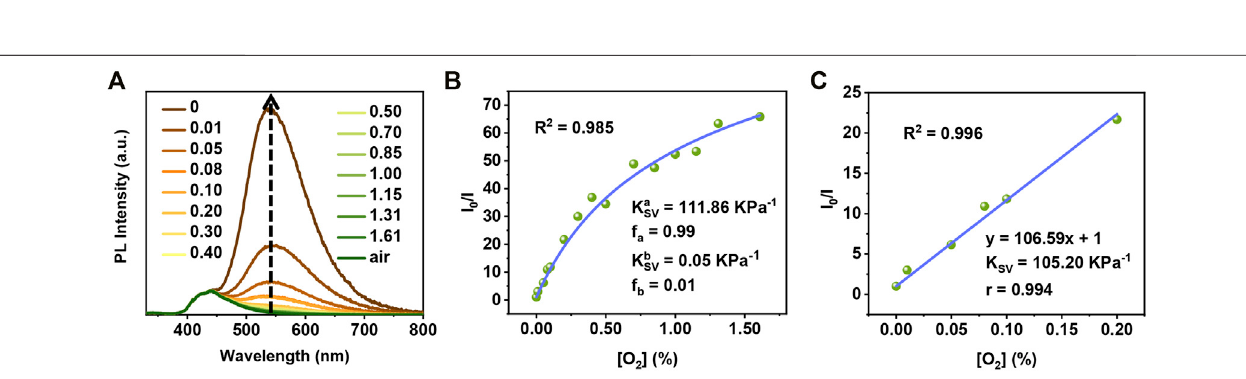
FIGURE 4 | (A) Emission spectra of TA2P Zeonex ® fi lm at different oxygen concentrations. (B) The Demas model curve of TA2P Zeonex ® fi lm ( fi tting range: 0% – 1.61%). (C) The Stern – Volmer curve of TA2P Zeonex ® fi lm ( fi tting range: 0% – 0.20%).